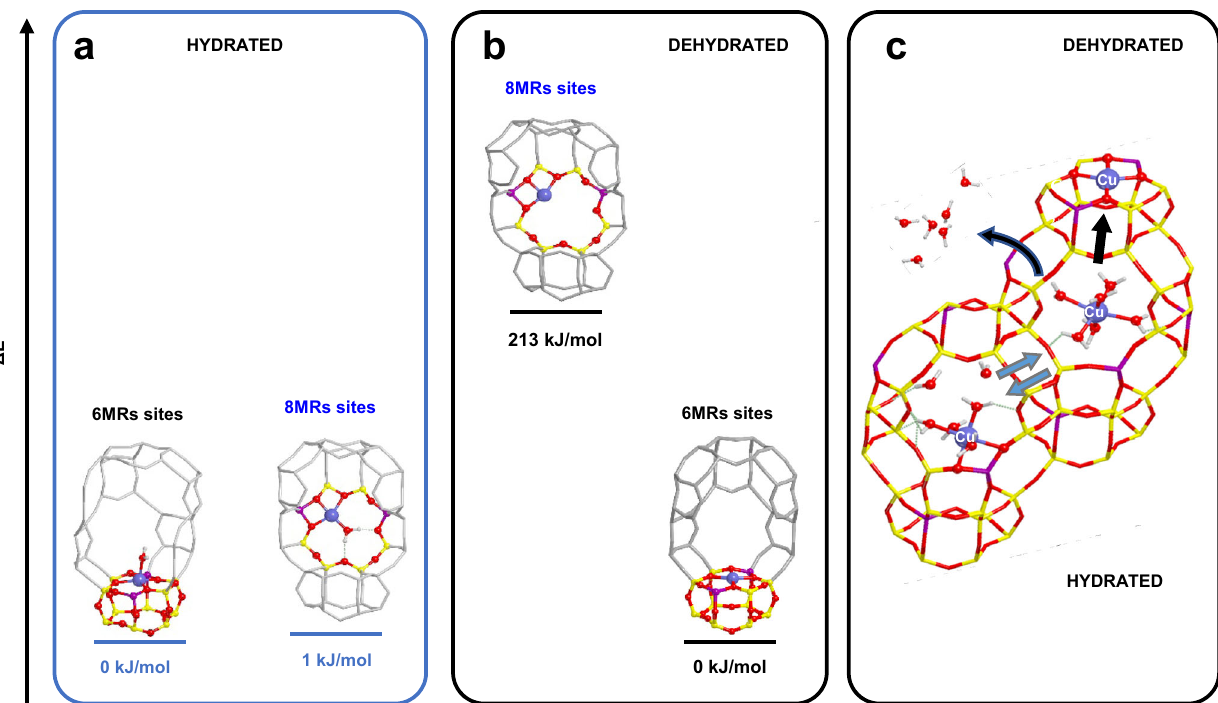
Fig. 5 Computed energies of hydrated and dehydrated Cu-CHA models. a Hydrated and b dehydrated Cu II species in 6MRs and 8MRs sites with the corresponding relative electronic energy per unit cell. c Picture of the Cu II dynamics inside the CHA framework due to the presence of water molecules. Some relevant atoms are represented by balls-and-sticks (colour code: medium blue Cu, yellow Si, violet Al, red O, white